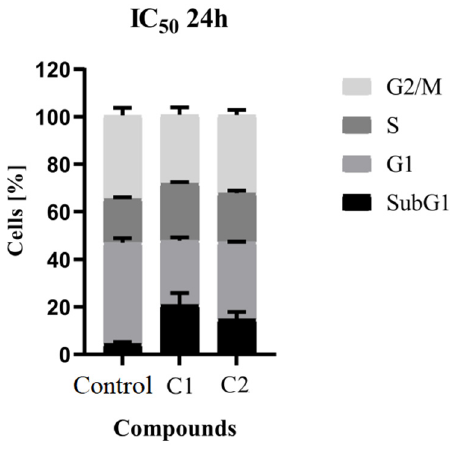
Figure 5. Cell cycle changes in phase distribution of HeLa cells induced by investigated compounds 24 h after treatment.